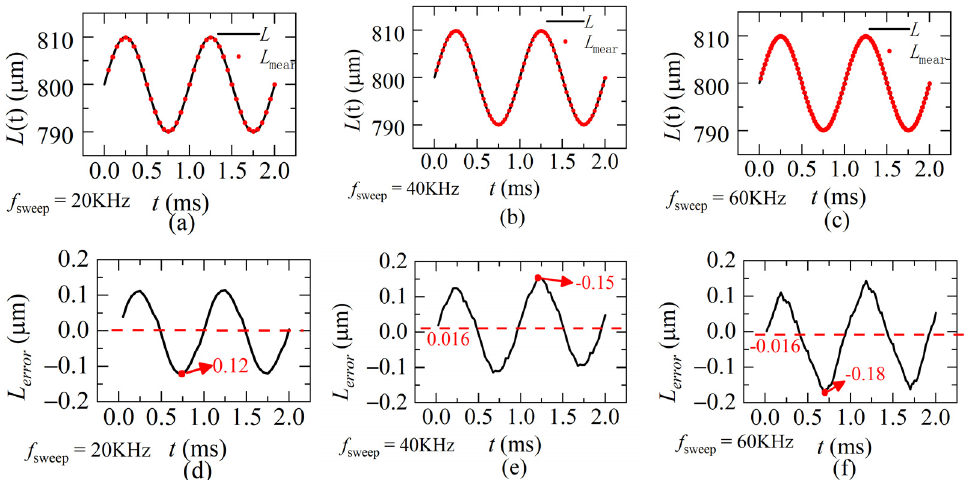
Figure 10. The simulation distances and the errors. L is the ideal distance, L mear is the demodulated distance, L error is the demodulation error between L and L mear ( a , d ) f sweep = 20 KHz ( b , e ) f sweep = 40 KHz ( c , f ) f sweep = 60 KHz ( L (0) = 800 μ m, ω = 1 KHz, A = ±10 μ m).